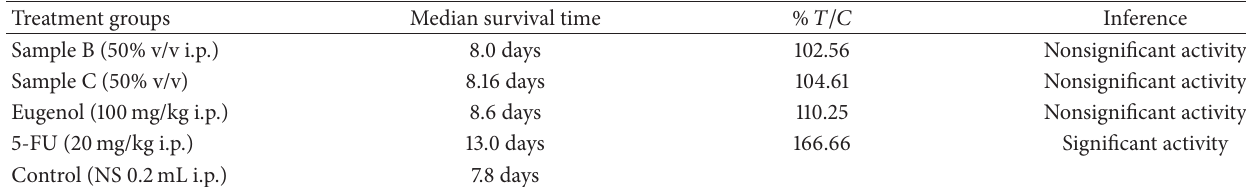
Table 1: Antileukemic activity of selected honey and